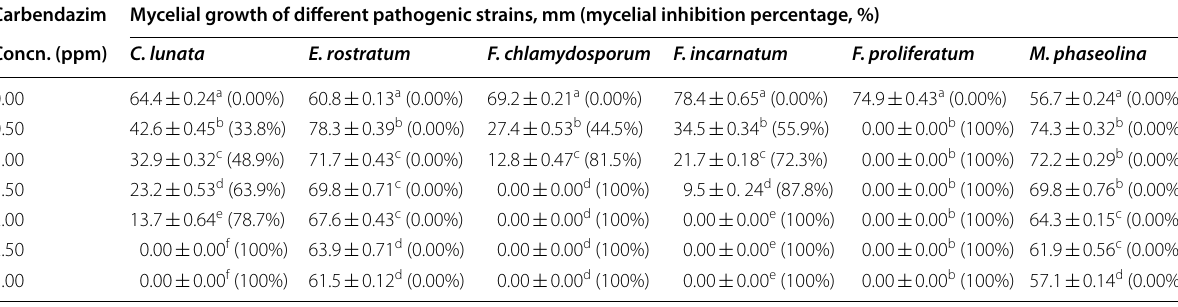
Different superscript letters in the same column indicate a significant difference at P < 0.05 Data are means of results from triplicate experiments